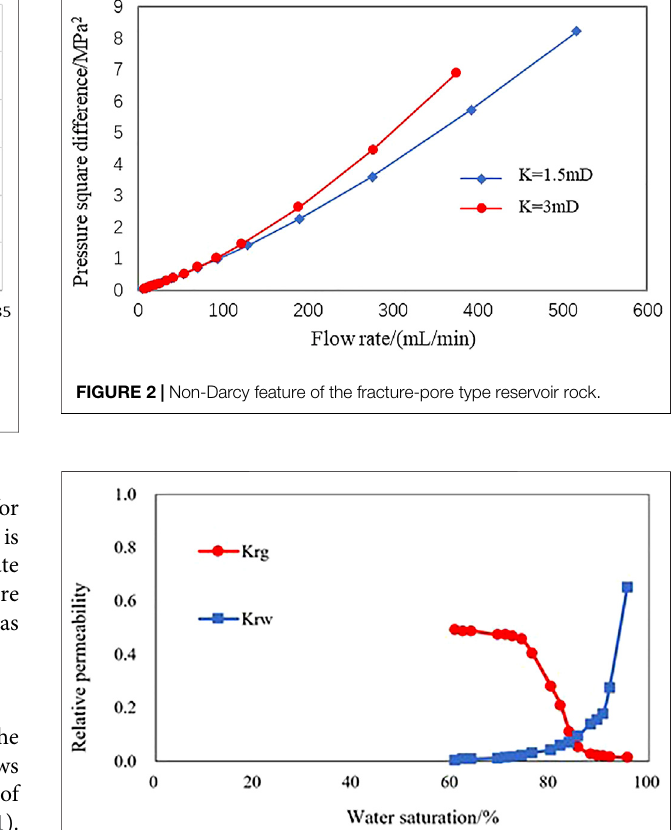
FIGURE 3 | Two-phase relative permeability of gas and water for the